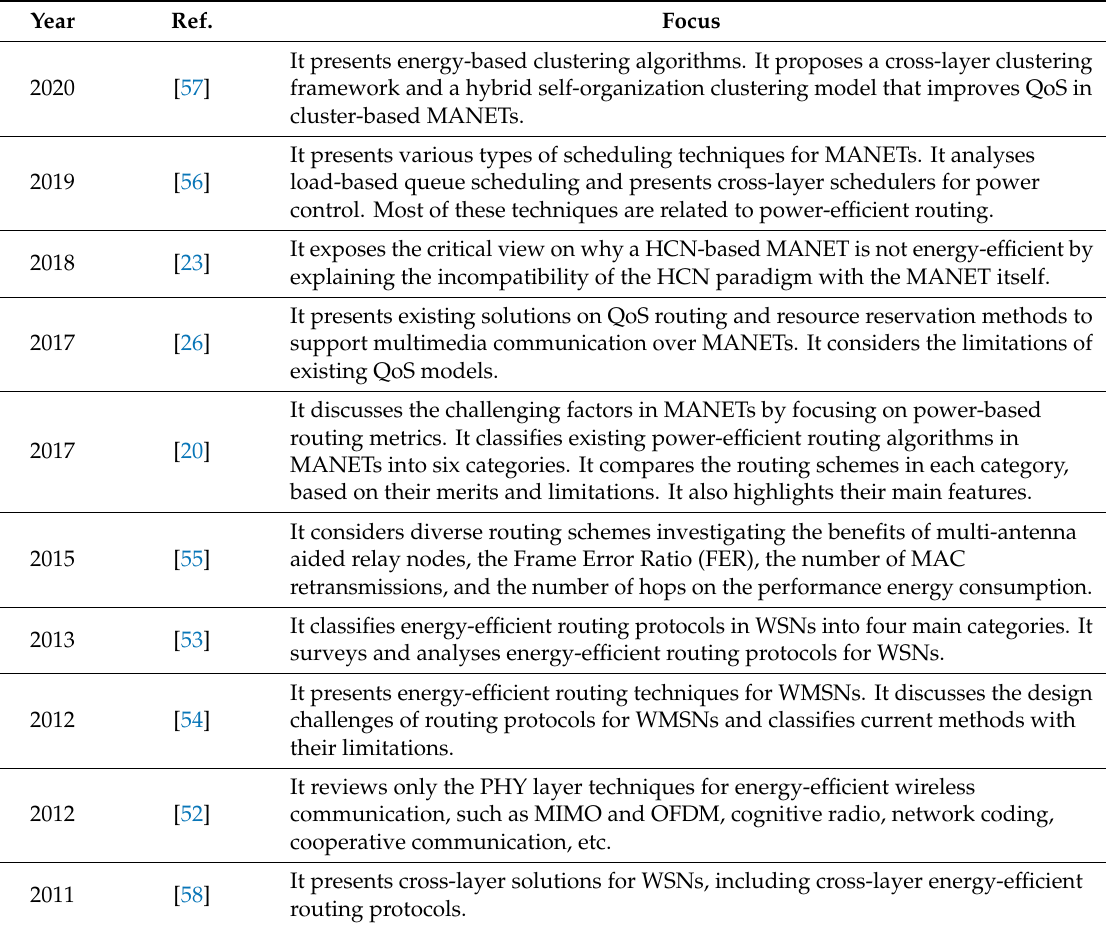
Table 1. Previous surveys that summarize research into power-e ffi cient routing in mobile ad hoc networks